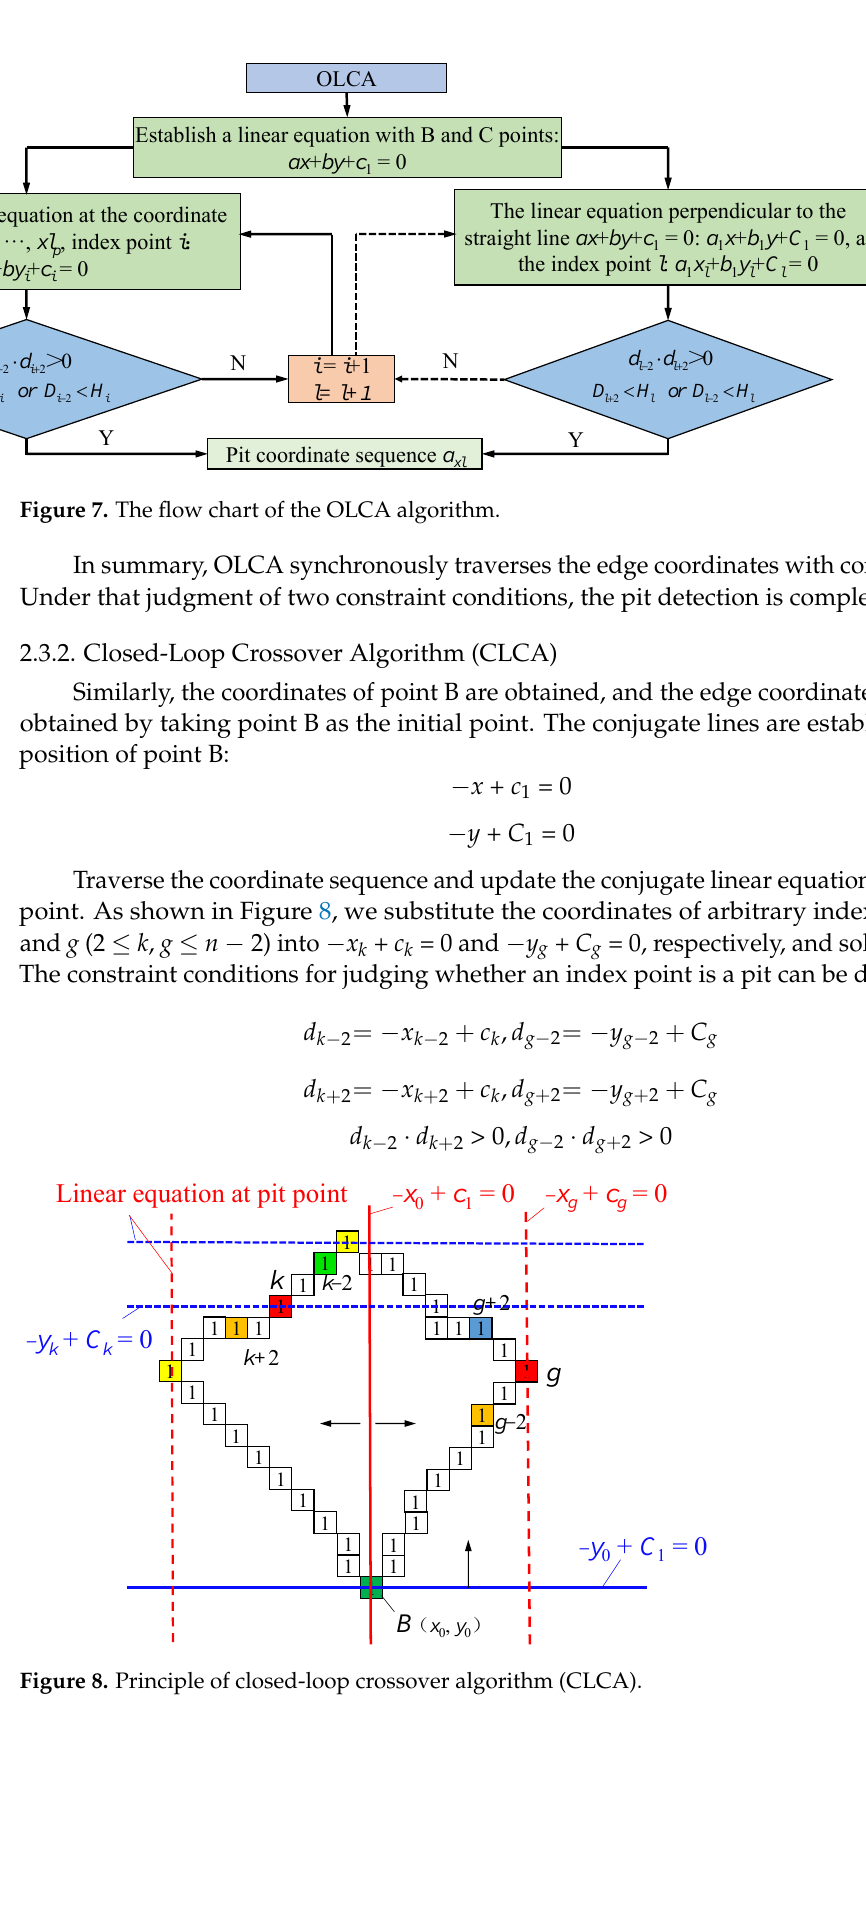
Figure 9. The flow chart of the CLCA algorithm. 2.3.3. False Pit Rejection and Image Segmentation Methods a xl includes true and false pits [32]. False pits include: ① Pits caused by circumferen ‐ tial concave defects of coal and gangue. Suppose the edge of irregular coal and gangue has a concave defect area of more than 50 pixels. More pits will be calculated in that case, as shown in Figure 10a. ② Calculate more pits on both sides of proper holes. The interval between the index point and the front and back points is 2 ‐ pixel steps. The pixels meeting the constraint conditions in these two steps are considered pits, as shown in Figure 10b. Figure 10. Analysis of the reasons for the existence of false pits: ( a ) Extract that number of pixel in an area of 11 × 11 centered on a pit, ( b ) False pits on both sides near the true pits.